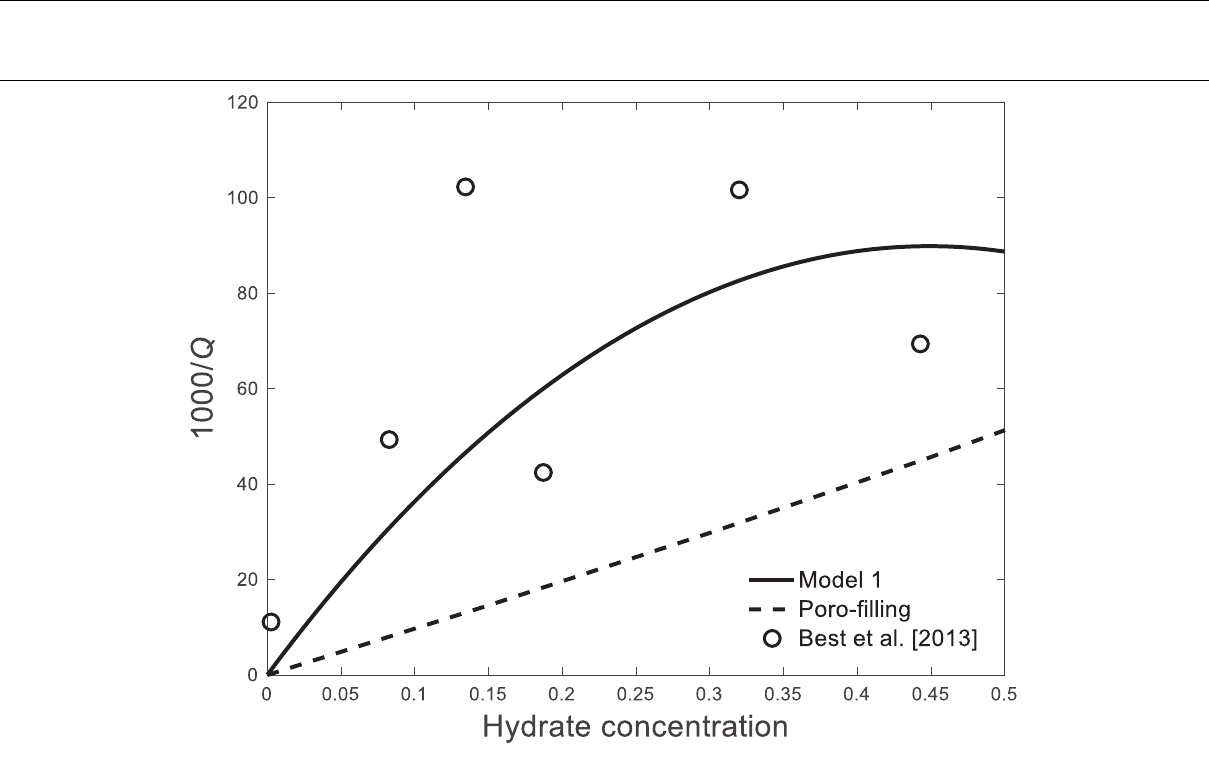
Frontiers in Earth Science |